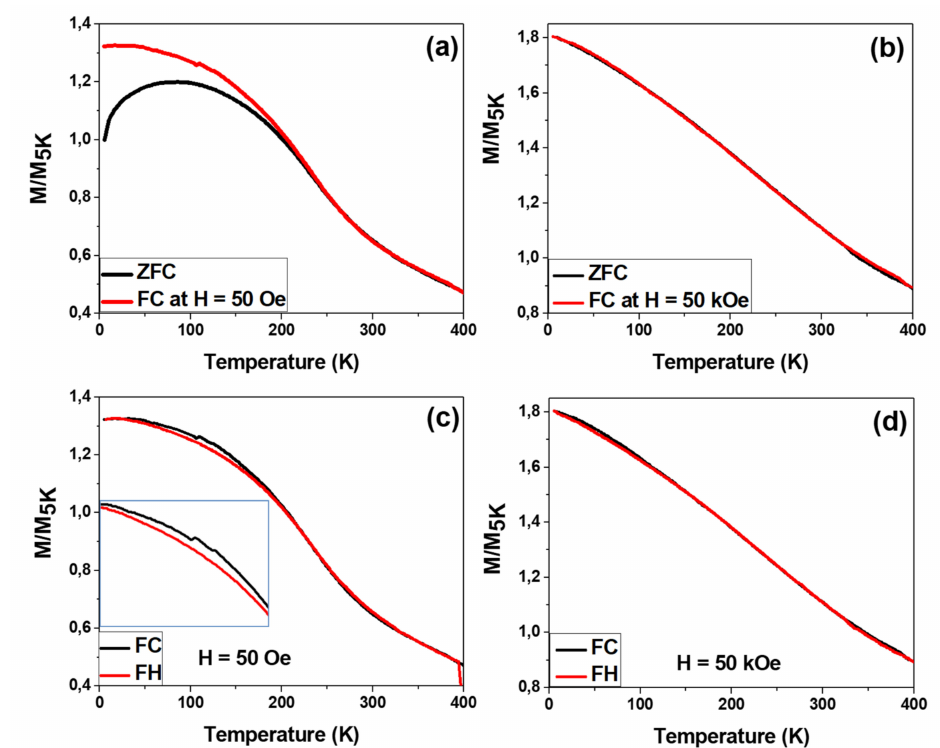
Figure 4. ( a , b ) Zero field cooling (ZFC), field cooling (FC) of Co 2 FeSi G-CMMWs at temperature range 400 K to 5 K with different applied magnetic field low field 50 Oe and high magnetic field 50 kOe, respectively. ( c , d ) FC from 400 K to 5 K and field heating (FH) from 5 K to 400 K of Co 2 FeSi G-CMMWs with different applied magnetic field low field 50 Oe and high magnetic field 50 kOe,